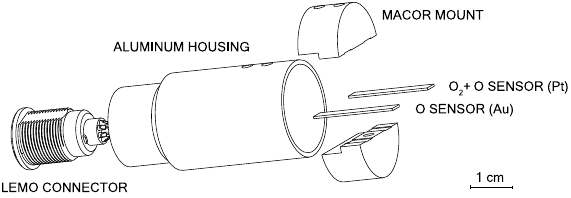
Figure 3. FIPEX head with two sensors (O and O + O 2 ) mounted in a common housing.